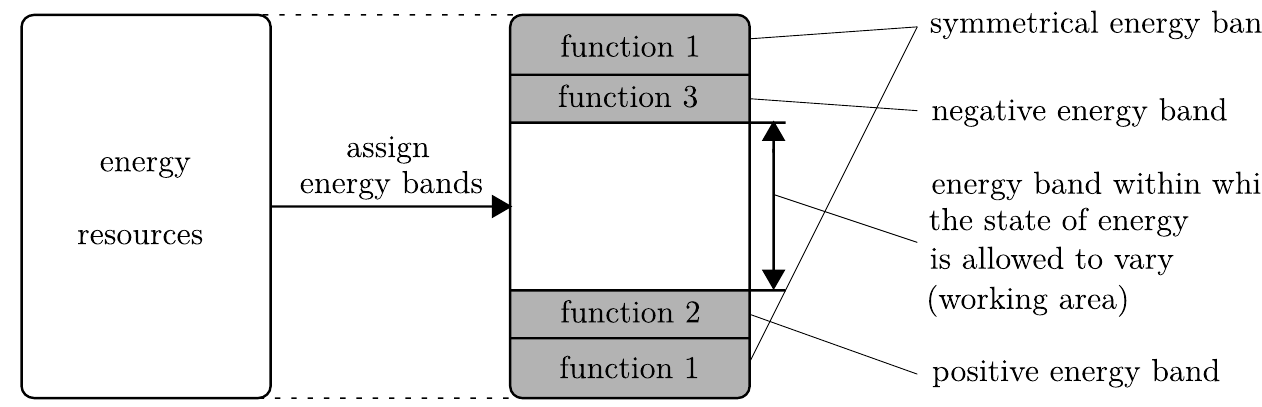
Figure 2. Concept of allocation of virtual BESS for each function on the example of assignment of energy bands for each function in a specific time slot. The grey color marks the reserved energy band of corresponding functions.